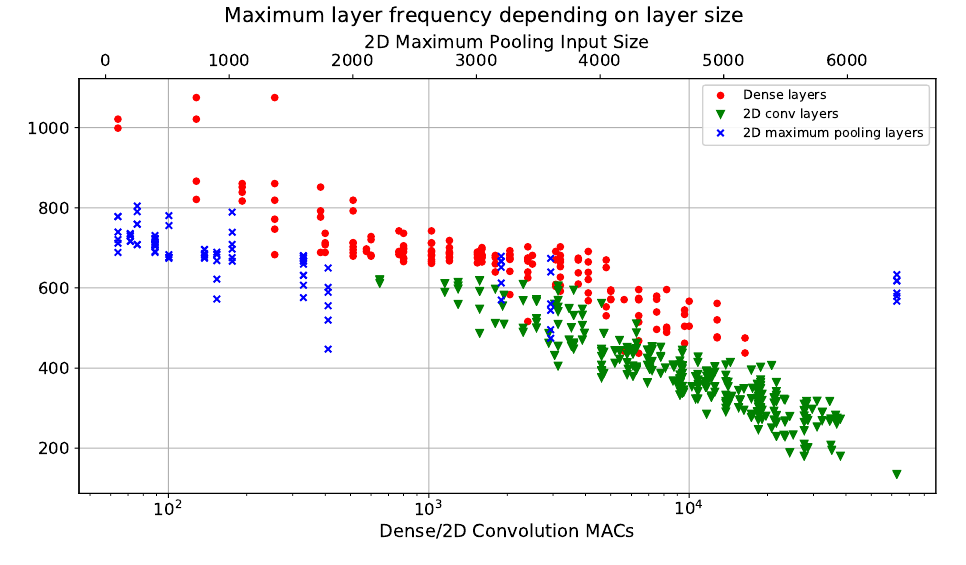
Figure 3. Plot showing the maximal layer frequency for the di ff erent layer types as a function of their complexity in terms of multiply-accumulate (MAC) operations.